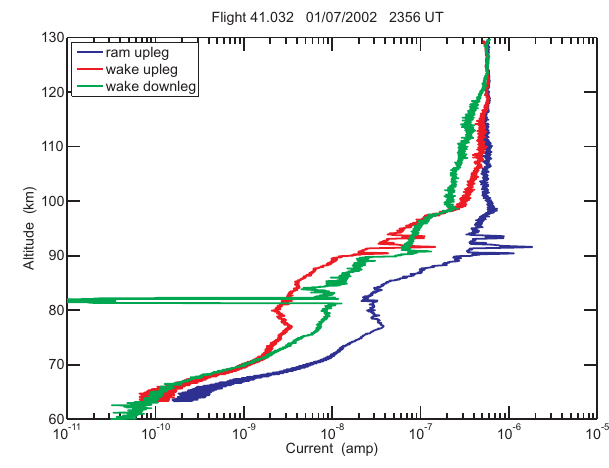
Fig. 12. Comparison of electron current measurements for Flight 41.032 (1 July 2002, 23:56